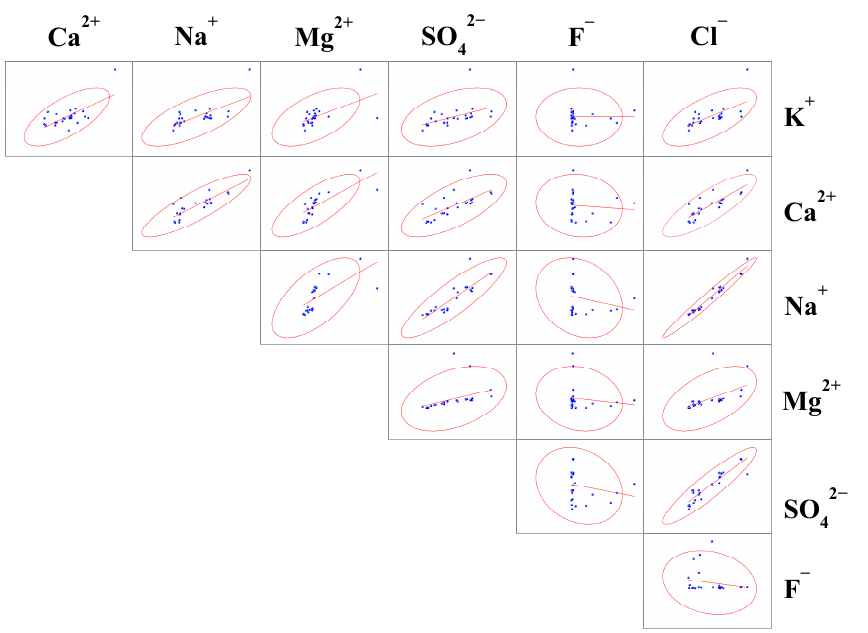
Figure 2. Correlation matrix arrangement of the major ion concentrations of water samples in the study area. Each red ellipse indicates a 95% confidence interval. Table 2. The correlation coefficients of the major ions of water samples in the study area, n = 27.